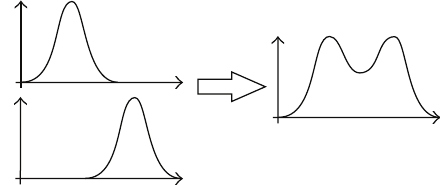
Figure 2: Depiction of capturing the complexity of the high- dimensional target track estimation space and mapping it to the surveillance area. This forms the target density